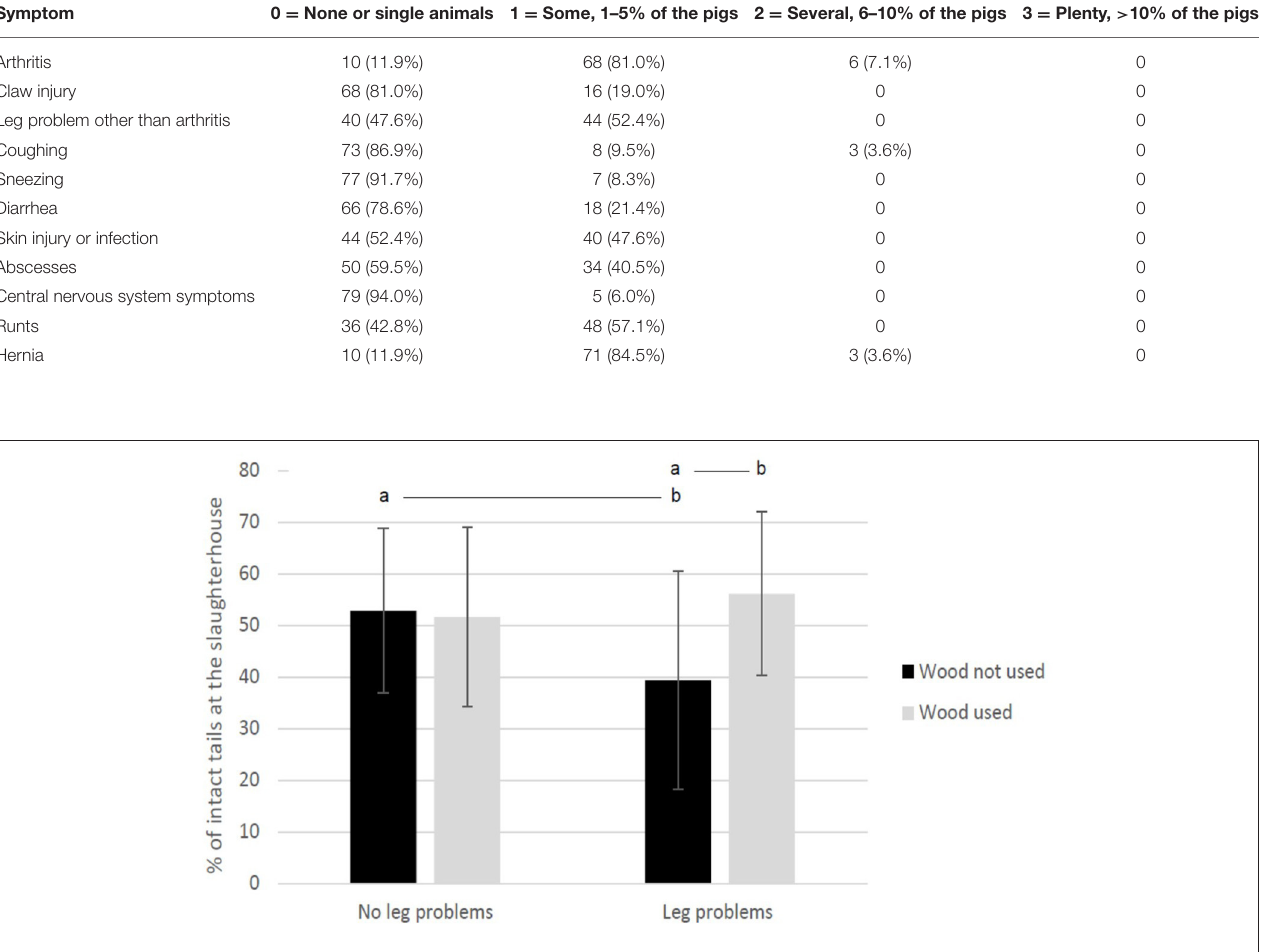
FIGURE 5 | Percentage of undocked, intact tails of finishing pigs evaluated at the slaughterhouse. The pigs originated from 84 herds, where the herd veterinarian collected the data during one herd health visit. The results are shown separately for herds using wood as enrichment and having leg problems other than arthritis present in the herd during the herd visit (interaction in the regression model). Different letters represent statistical difference: ab p < 0.01.